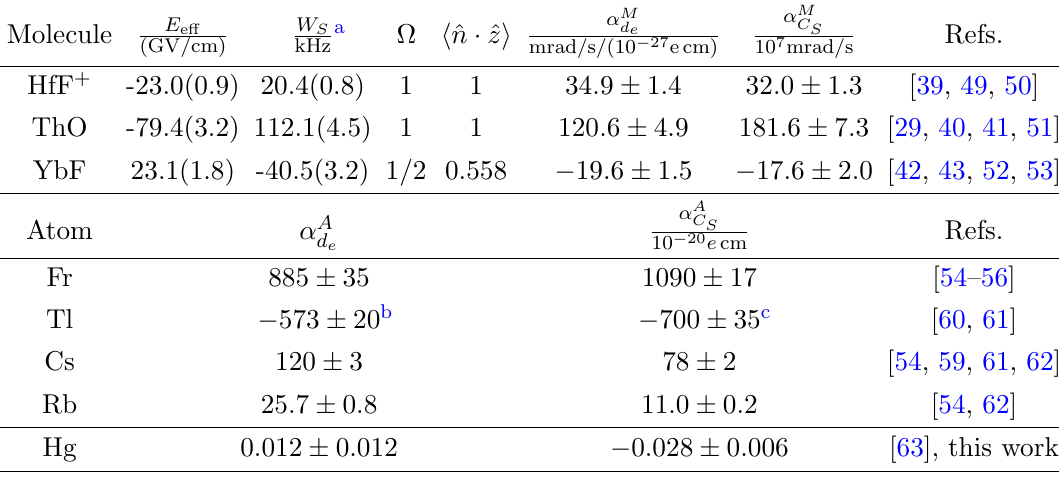
are de(cid:12)ned d e ;C S